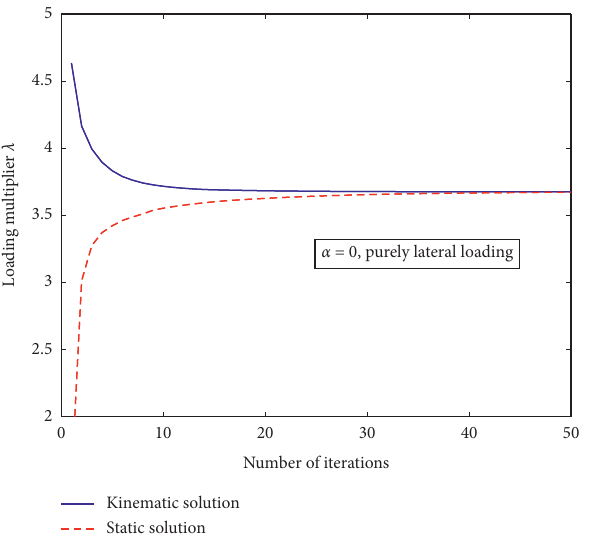
α = 5 Curve 2: response for softening soil without P – Δ effect Curve 3: response for softening soil with P – Δ effect Curve 4: limit load for nonsoftening soil without P – Δ effect Curve 5: limit load for soil with residual strength without P – Δ effect Figure 9: Lateral load-displacement response of a single